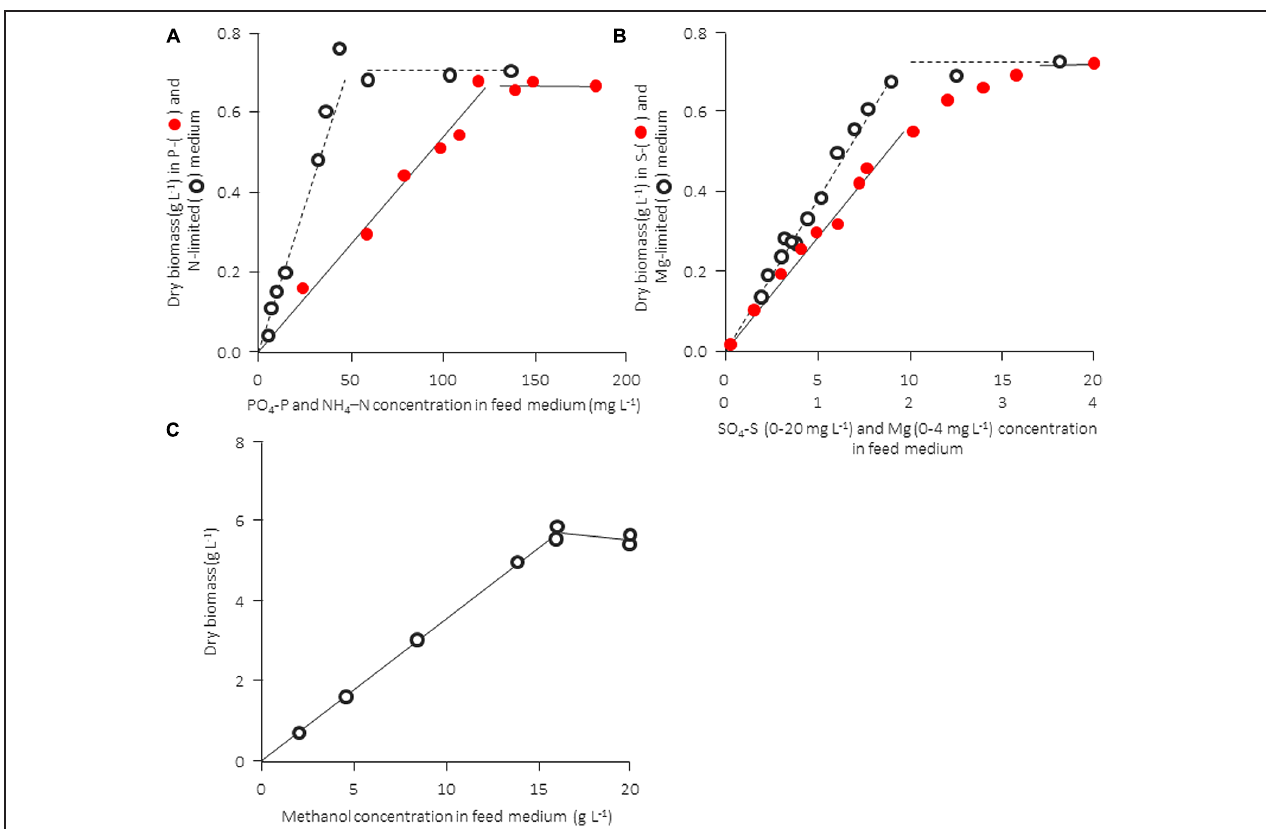
FIGURE 1 | Experimental confirmation of stoichiometric limitation of growth of different nutrients for a bacterial (Cometta et al., 1982) and a yeast culture (from Egli, 1980). Both microbial strains were cultivated in a chemostat culture at a fixed dilution rate. A distinct transition from limitation to excess is observed for carbon-,